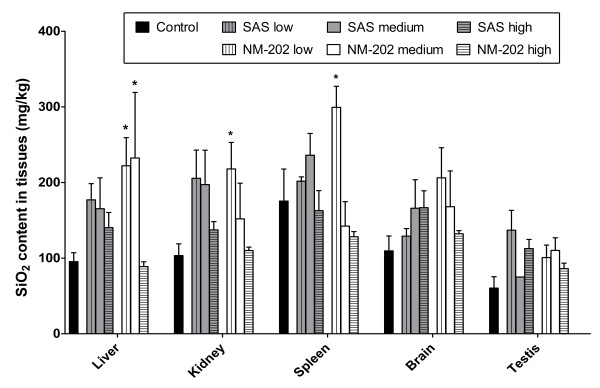
Silica content in organs of animals orally exposed to SAS or NM-202 for 28 days. Silica content was measured by ICP-MS and presented in mg silica/kg tissue (mean ± standard error of the mean; n = 5). * Significant difference versus the control (p < 0.05).